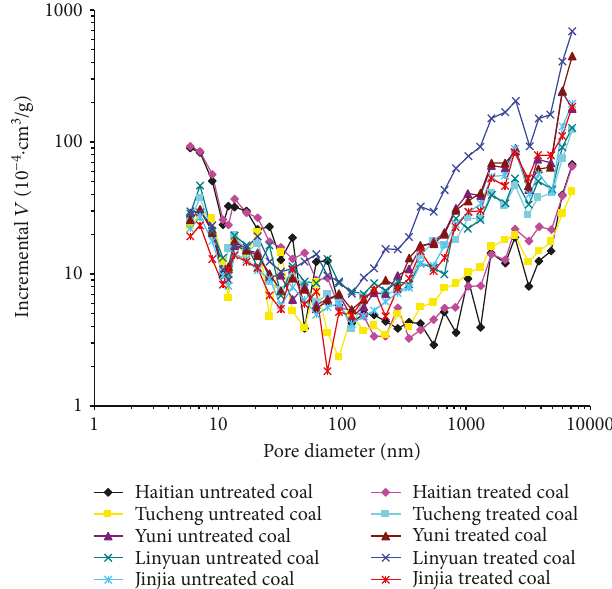
Figure 2: Pore size distributions of samples. Table 2: Pore volumes of the untreated and CS